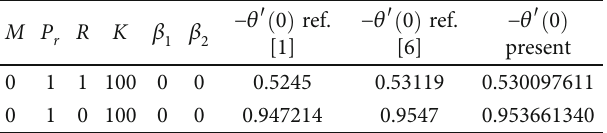
Figure 1: Flow geometry. Table 1: Nusselt number − θ ′ ð 0 Þ .